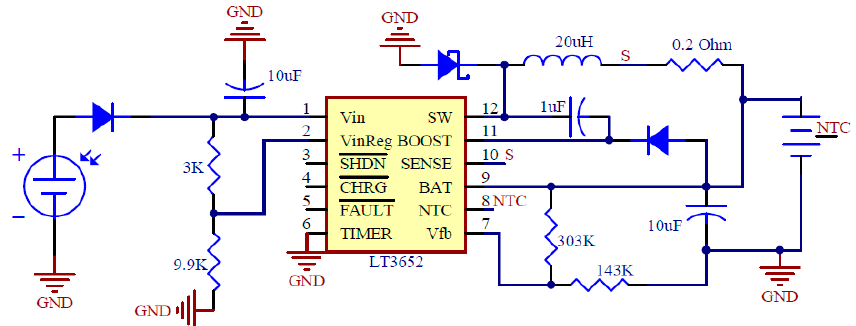
Figure 3. Electrical diagram of battery charging system from solar panels corresponding to PV4.